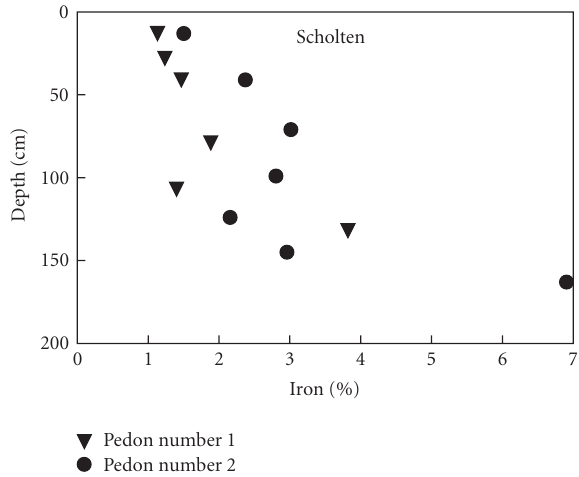
Figure 2: Soil profile Fe depth distribution for the Scholten (Fragiudults) pedons.